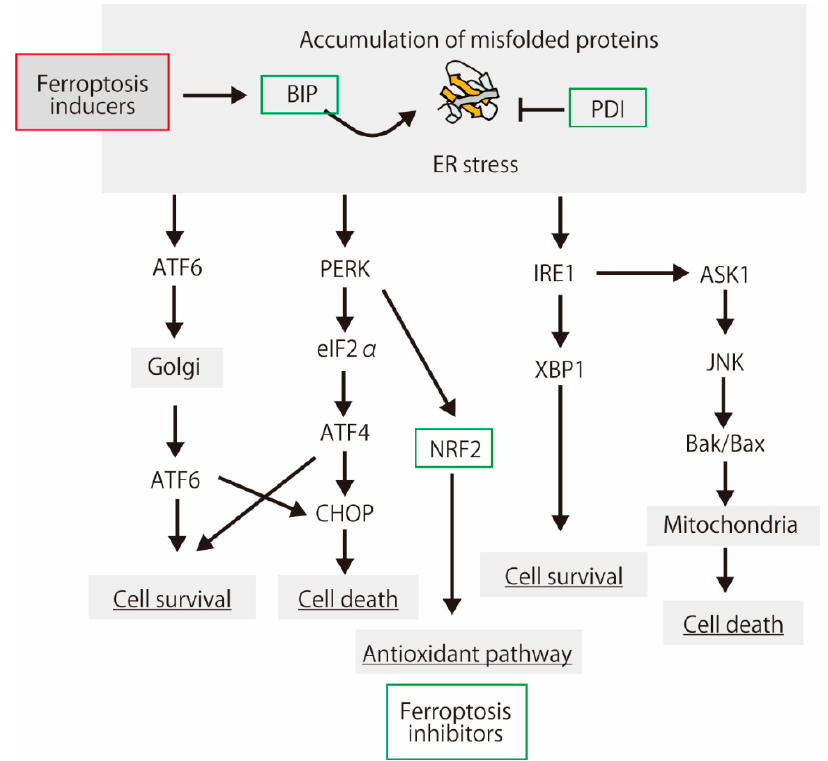
Figure 3. A schematic showing the protein aggregation, endoplasmic reticulum (ER) stress response, and cell fate. Protein aggregation is a main feature of the neurodegenerative diseases [88]. Some of the proteins induced by ER stress have ferroptosis-inhibiting activities.